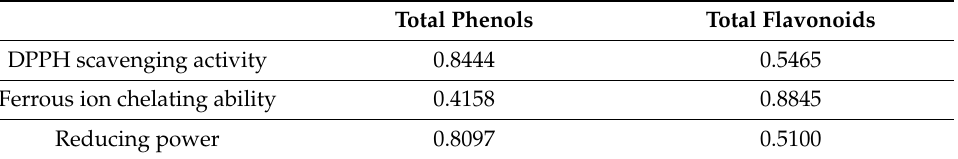
Table 3. The Pearson correlation coefficients (r) between total phenols, total flavonoids and antioxidant abilities.